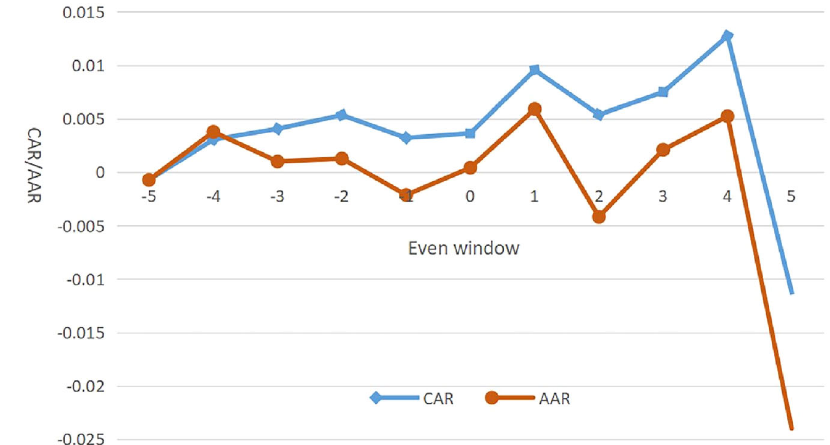
Fig. 1 Average abnormal returns and cumulative abnormal returns trends. Trend of AARs and CARs for the event window ( t − 5 – t + 5